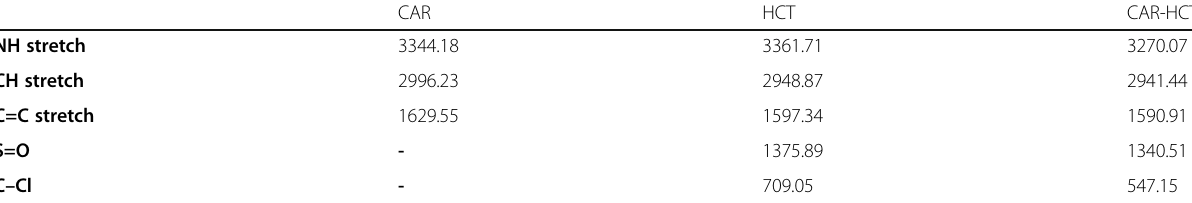
Table 3 Relevant bands of CAR, HCT, and CAR-HCT in Raman spectroscopy